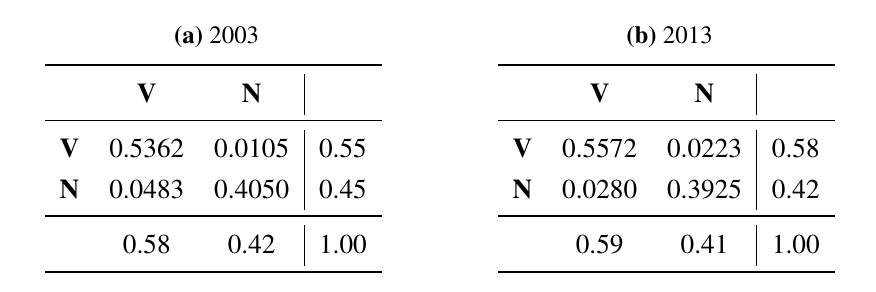
Table 3. Confusion matrices for the ( a ) 2003 and ( b ) 2013 classifications. “V” stands for “Vegetated” surfaces, whilst “N” for “Non vegetated”. Matrices are expressed in terms of proportions of area.